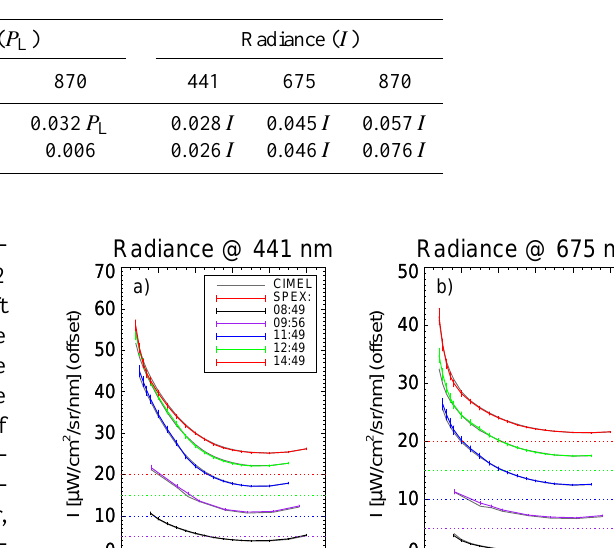
Table 1. Summary of the polarimetric and radiometric calibrations of the groundSPEX instrument. The random error in the polarization is independent of the degree of linear polarization P L , whereas the other errors are relative errors.